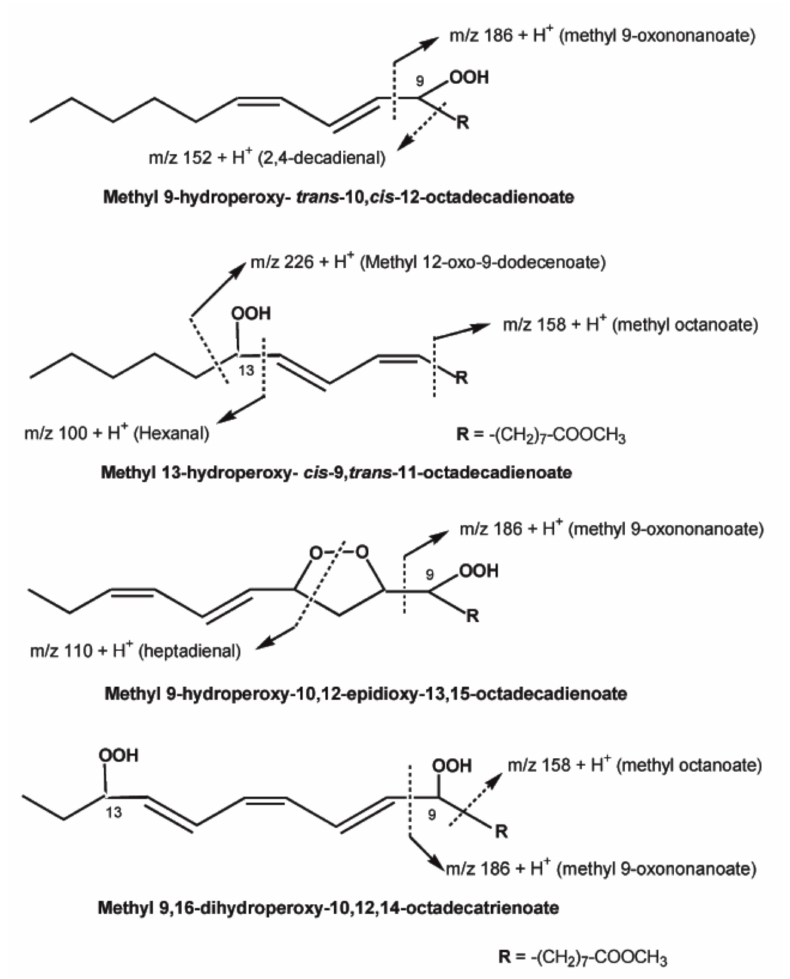
Figure 11. Mass-fragment ions obtained by chemical ionization mass-spectrometry (CI-MS) analysis of 9- and 13-hydroperoxides from oxidized methyl linoleate, and 9- hydroperoxy epidioxide and 9,16- dihydroperoxide from oxidized methyl linolenate. Adopted with permission from [10]. Copyright 2005, Elsevier Science; Woodhead